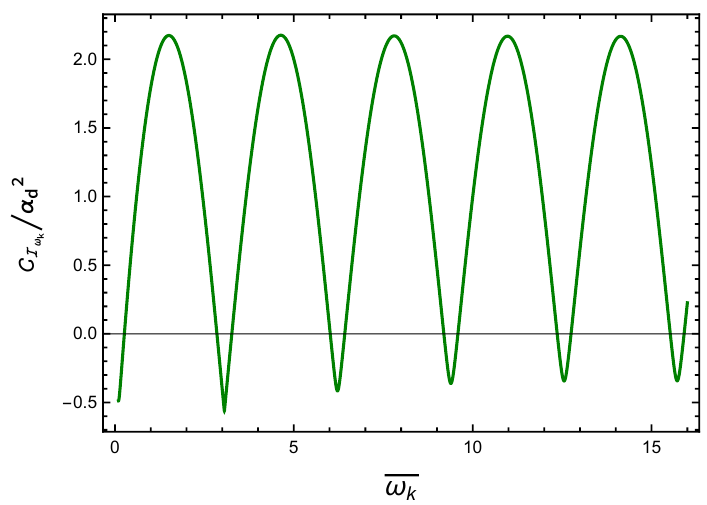
, signifying the concurrence, is plotted for two outgoing null Figure 12 . The quantity C I /α 2 d ωk detectors in a (1 + 1) dimensional de Sitter spacetime with respect to the dimensionless frequency of the field ω for fixed dimensionless detector transition energy ∆ E = 0 . 5 , and fixed d/α k